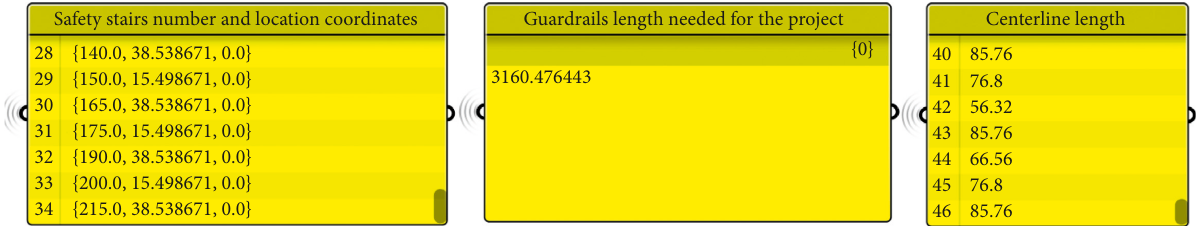
Figure 13: Quantity take-offs statistics